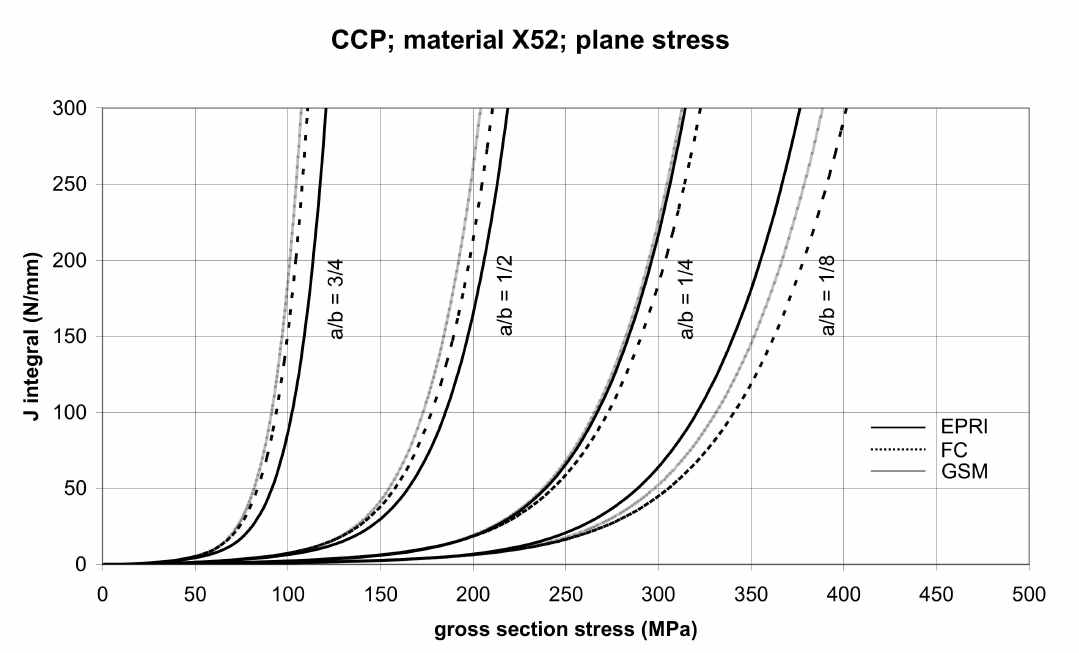
Figure 6. Comparison of J integral for CCP X52 steel specimens in the plane stress condition as determined by the EPRI, GSM, and FC methods.